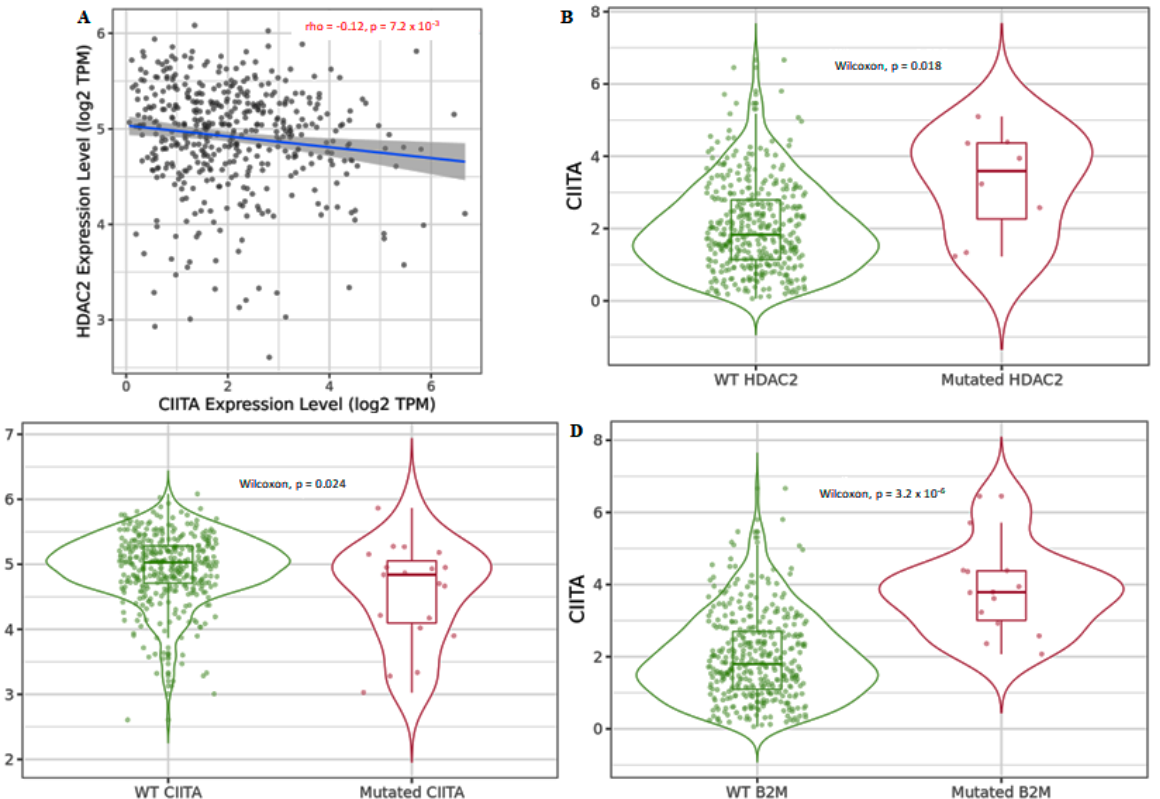
Figure 4. HDAC2 and CIITA are negatively regulated in COAD tumors. ( A ) Correlation between HDAC2 and CIITA ; data shown have been purity-adjusted. Spearman’s rho value and statistical significance: positive correlation = p < 0.05, ρ > 0; negative correlation = p < 0.05, ρ < 0; not significant = p > 0.05; ( B ) Violin plot showing the differential expression of CIITA and wild-type HDAC2 versus the mutated HDAC2 form; ( C ) violin plot showing the differential expression of HDAC2 and wild-type CIITA versus the mutated CIITA form; ( D ) violin plot showing the differential expression of CIITA and wild-type B2M versus the mutated B2M form. Data shown have been purity-adjusted. Data are shown in Log2 scale (fold change): higher level in mutants = p < 0.05, Log2FC > 0; lower level in mutants = p < 0.05, Log2FC < 0; not significant = p > 0.05.